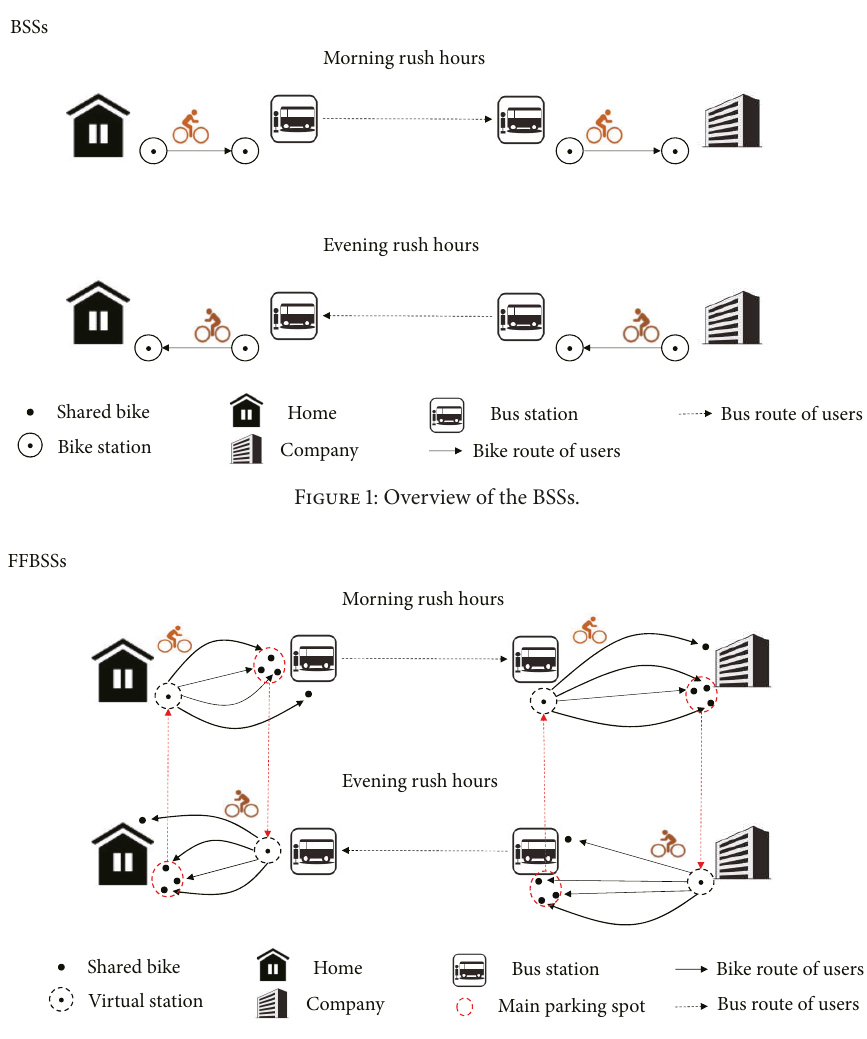
Figure 2: Overview of the